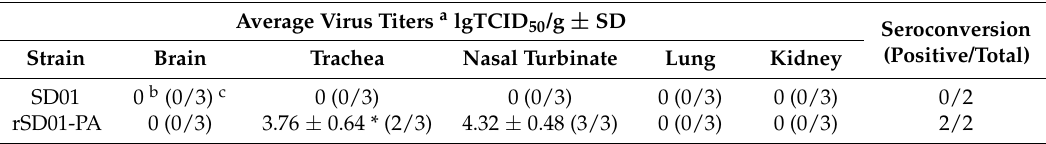
Table 5. The results of virus titer test in guinea